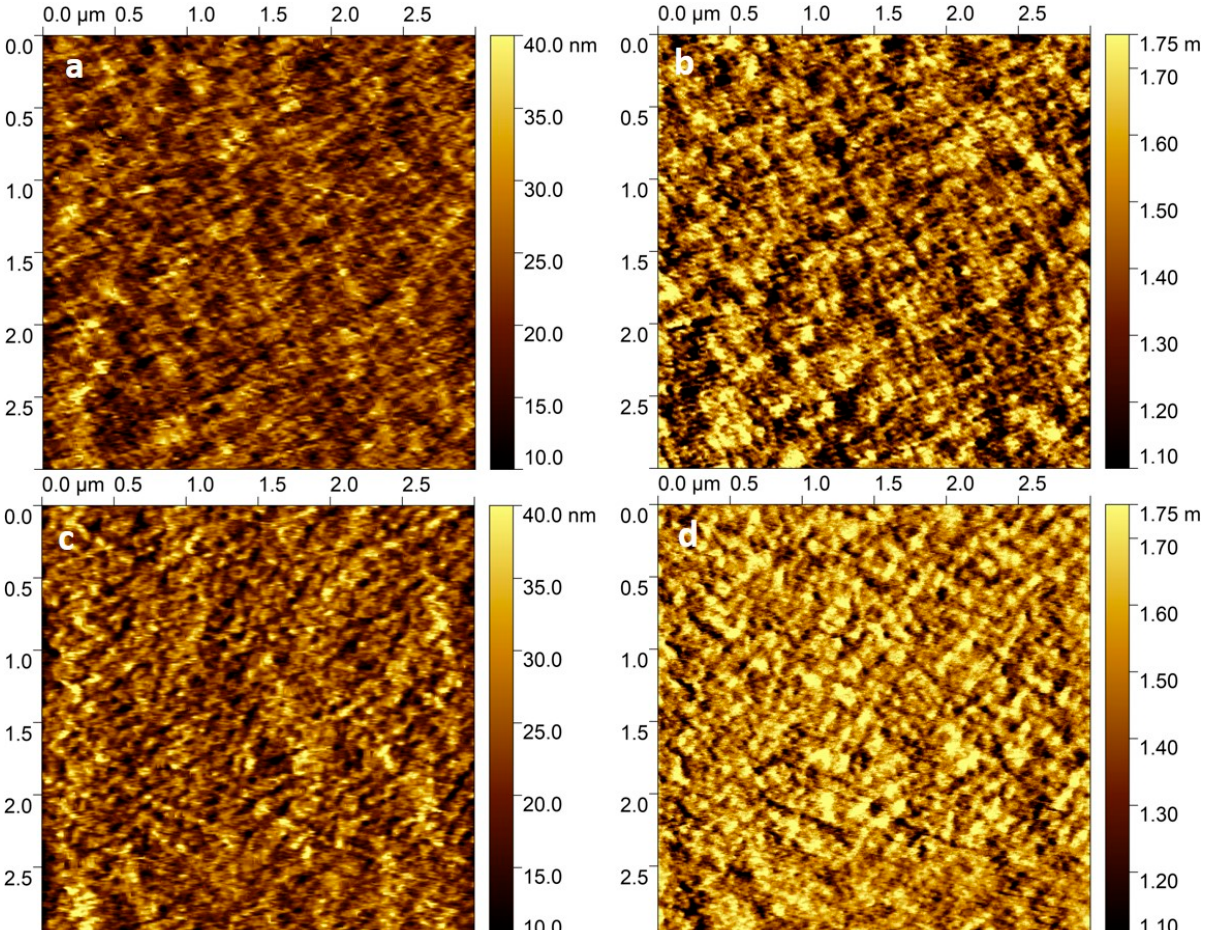
Figure 4. AFM topography ( a , c ) and phase ( b , d ) images of PBnDT-FTAZ:PCBM blend films with 0% ( a , b ) and 3% DIO ( c , d ). Table 1. Summary of Statistical Quantities of AFM Images.